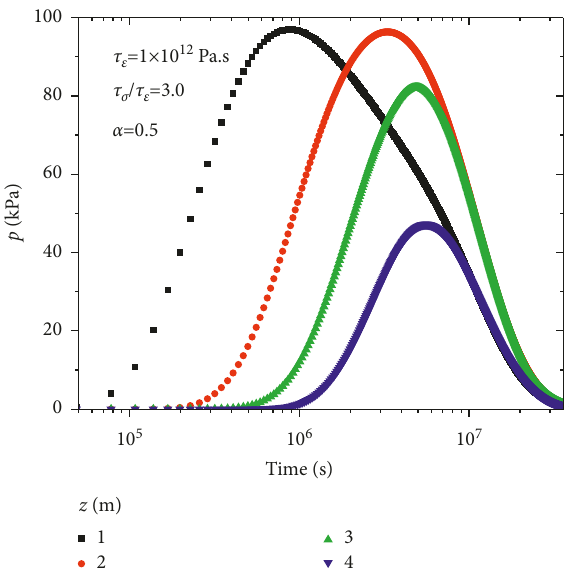
Figure 11: Influence of embedment depth on pore water pressure when τ